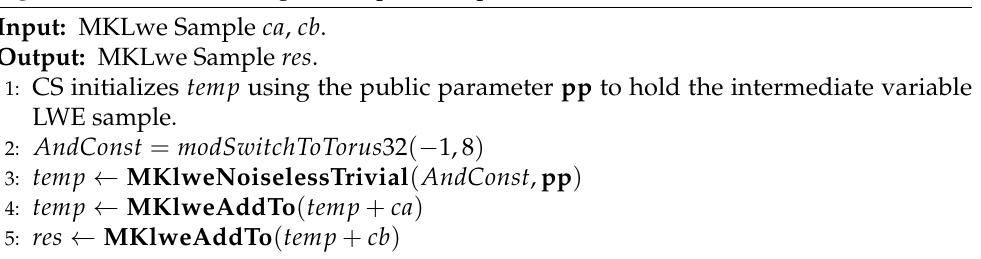
Algorithm 1 Secure AND gate computation protocol ( SC AND